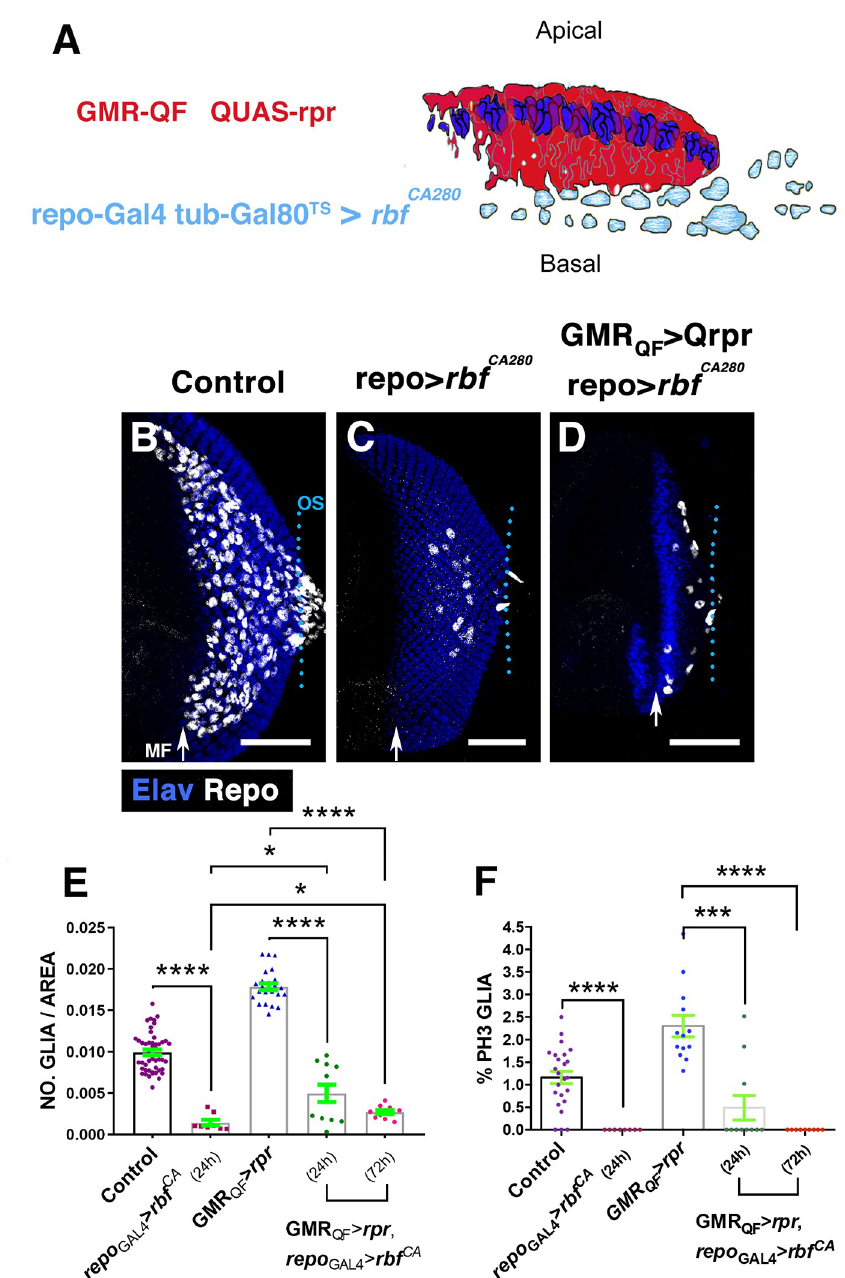
Fig 3. Overexpression of rbf CA280 in glial cells reduces the number of glial cells observed after cell death induction. (A) The schematic illustration represents a transverse section of an eye disc where the region marked in red (expression domain of GMR-QF) corresponds to the area of the discs that has been damaged using QUAS-rpr GMR-QF . Glial cells are indicated in light blue. repo-Gal4 drives the expression of UAS-rbf CA280 under the control of UAS specifically in glial cells. (B–D) Third instar eye discs stained with anti-Repo (white) and anti-Elav (blue). Control undamaged GMR-QF; tub-Gal80 ts repo-Gal4 eye disc (B), tub - Gal80 ts /+; repo - Gal4 / UAS-rbf CA280 (C) and GMR - QF ; tub - Gal80 ts /+; repo - Gal4 / UAS-rbf CA280 disc (D). The overexpression of UAS - rbf CA280 under the control of repo-Gal4 reduces the number of glial cells in undamaged (C) and damaged eye discs (D). (E) The graph represents the glial density of discs shown in B–D (Control, repo Gal4 -rbf 24hrs , GMR QF -rpr , GMR QF -rpr repo Gal4 -rbf 24hrs , and GMR QF -rpr repo Gal4 -rbf 72hrs ). (F) The graph shows the percentage of glial cells in mitosis (PH3 positive). Statistical analysis is shown in Table C in S1 Text. Error bars represent SEM. Scale bars, 50 μ m. The numerical data used in this figure are included in S1 Data. GMR, glass multiple reporter; rpr , reaper ; SEM, standard error of the